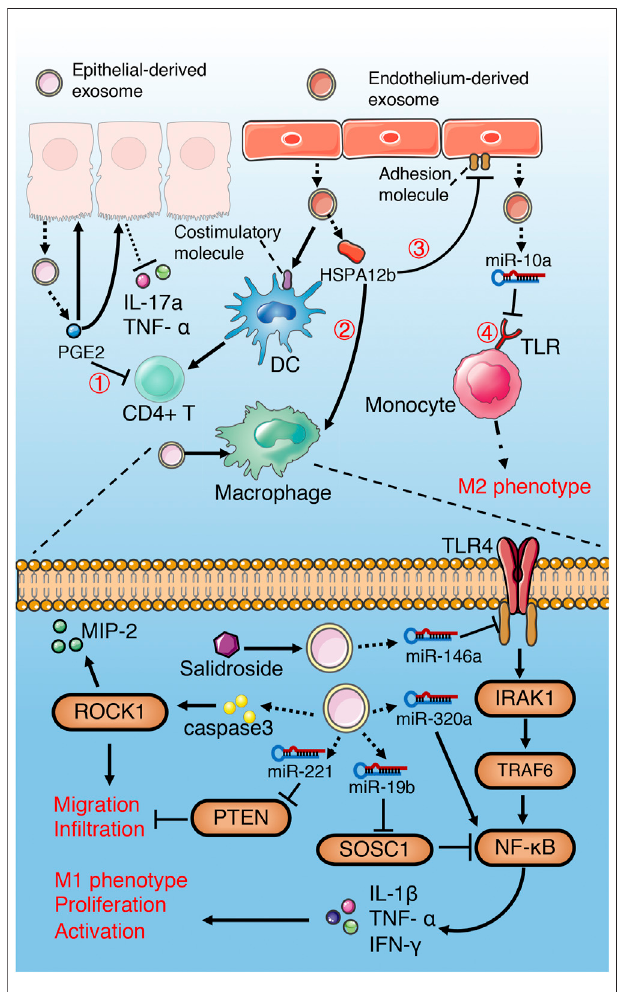
FIGURE 5 | Role of exosomes derived from epithelial and endothelial cells insepsis. Epithelium-derivedexosomes promoteactivation, proliferation, migration, in fi ltration and M1 polarization of macrophages through multiple miRNAs-mediated NF- κ B activation, PTEN inhibition and caspase3- mediated ROCK1 activation. However, salidroside can induce epithelial exosomes releasing miR-146a, which inhibit TLR4/IRAK1/TRAF6/NF- κ B signaling pathway. Exosomal PGE2 of IEC inhibit T cells through cAMP/PKA- dependent pathway ① , and decrease pro-in fl ammatory cytokines release via autocrine and paracrine. Exosomal HSPA12b of endothelium reduce pro- in fl ammatory cytokines release and adhesion of macrophages by Inhibiting NF- κ B ② andactivatingPI3K/Akt ③ signalingseparately.Endothelialexosomes can induce a M2-like phenotype in monocyte through Inhibiting TLR/IRAK4/ TAK1/NF- κ B ④ signaling pathway and promote DC maturation and T cell